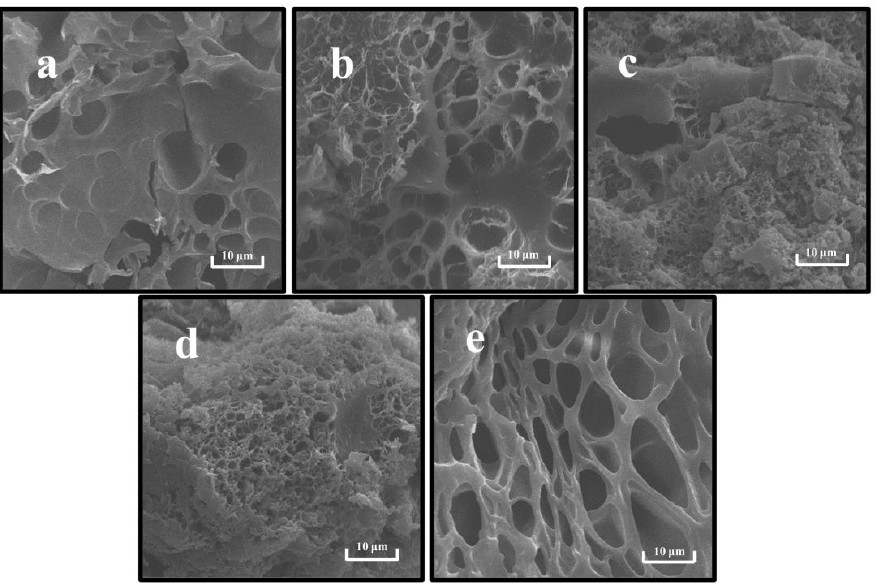
Figure 8. Scanning electron microscopy of composite gels at different SPI and PP ratios. ( a ) SPI-PP = 3/0; ( b ) SPI-PP = 2/1; ( c ) SPI-PP = 1/1; ( d ) SPI-PP = 1/2; and ( e ) SPI-PP = 0/3. Magnifi-